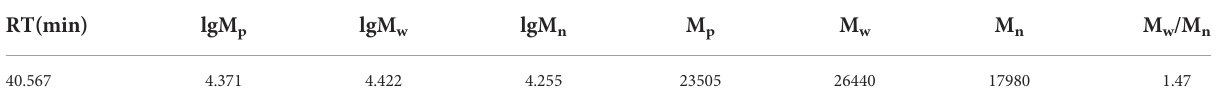
TABLE 4 Molecular weight results for